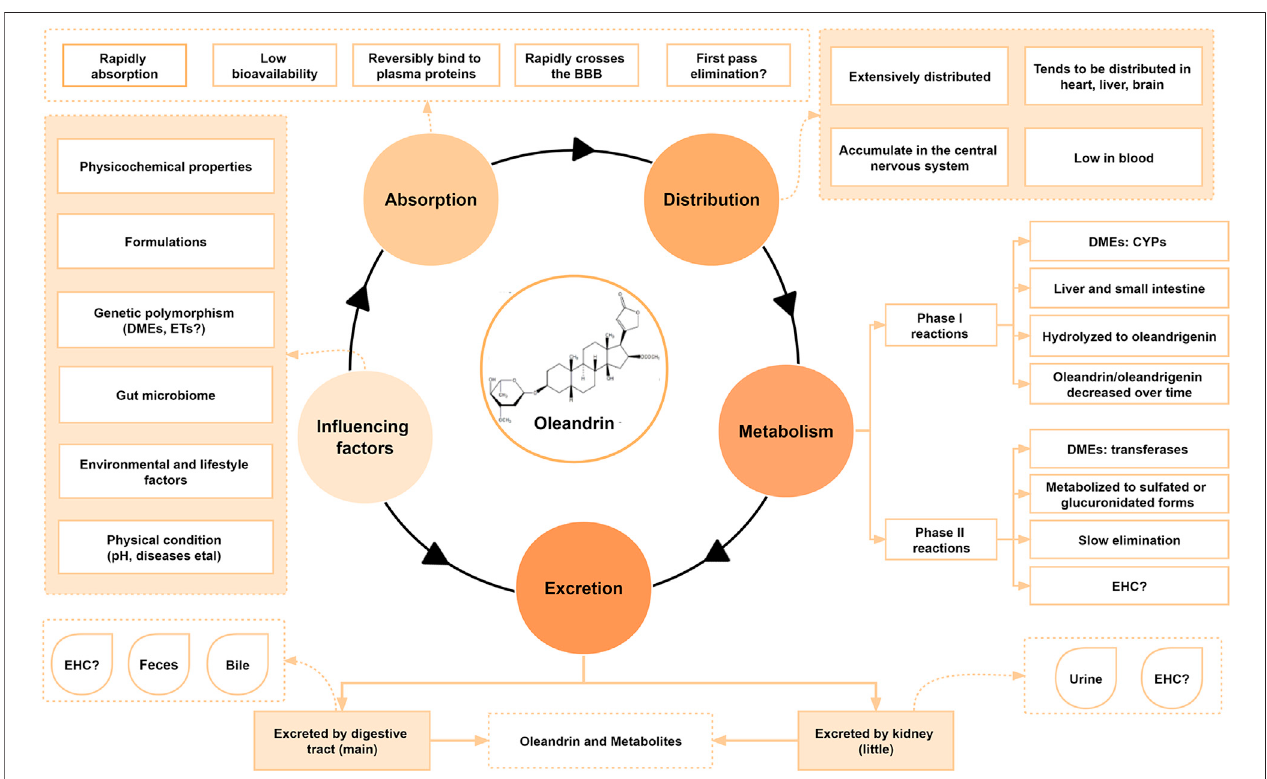
FIGURE 2 | Pharmacokinetic characteristics and in fl uencing factors of